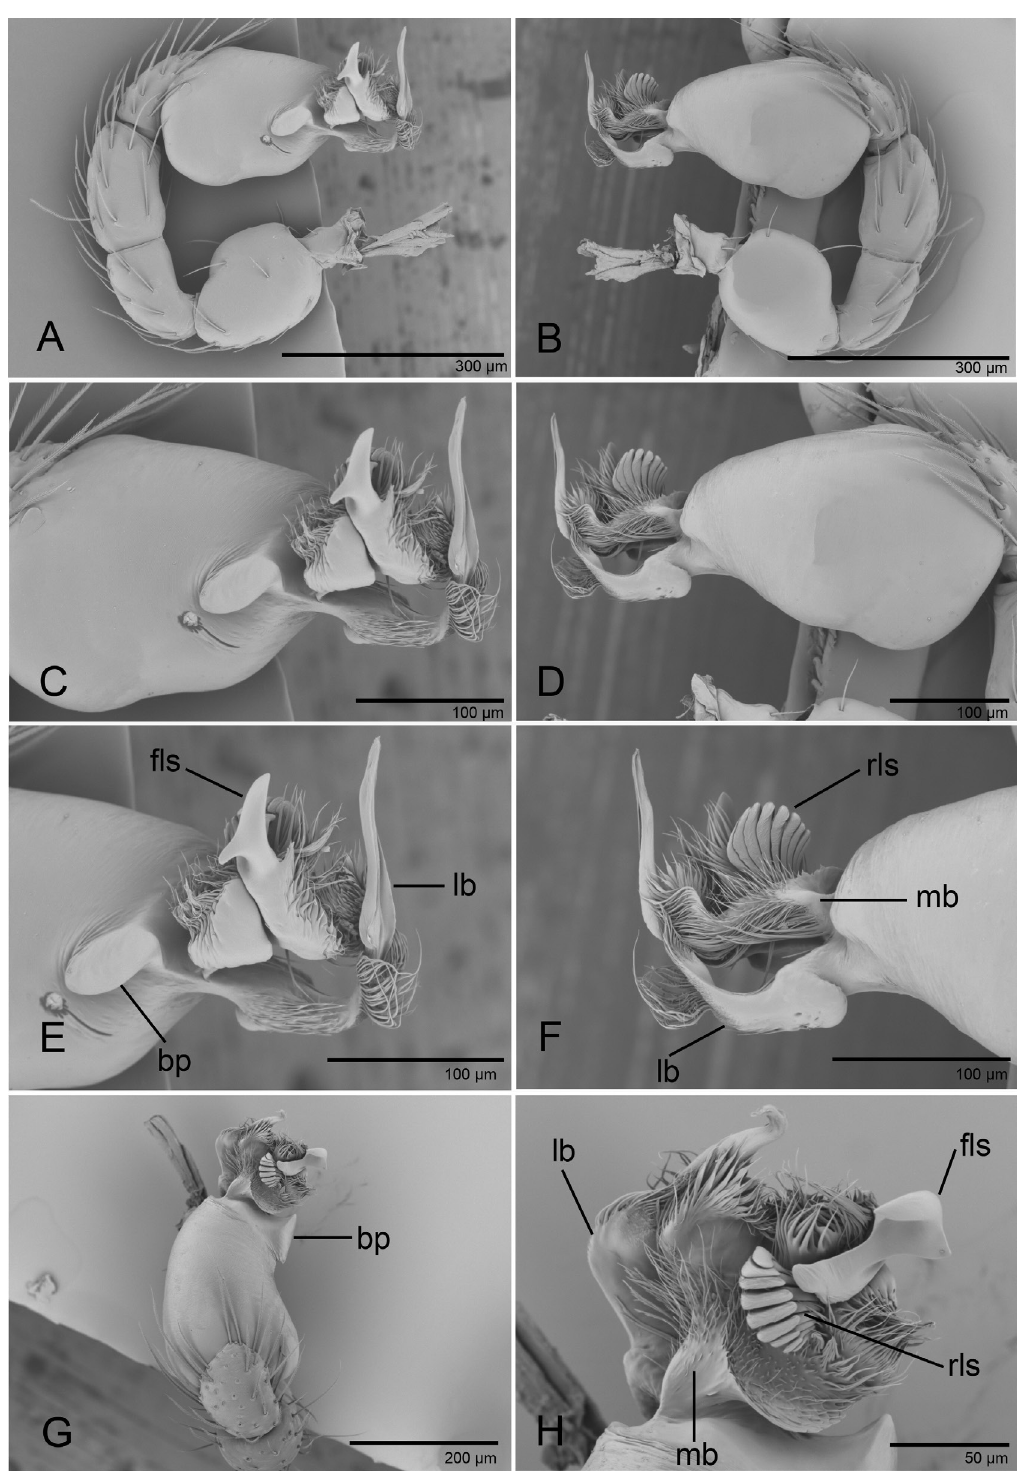
Fig. 6. Trilacuna jiuchi Tong, Zhang & Li sp. nov., left male palp, SEM, holotype, ♂ (SYNU-300). A – B , G . Prolateral, retrolateral, and dorsal views. C – D . Palpal bulb in prolateral and retrolateral views. E – F , H . Distal part of palpal bulb in prolateral, retrolateral, and dorsal views. Abbreviations: bp = basal protrusion; fls = fork like sclerite; lb = lateral branch; mb = median branch; rls = nine-teeth-rake like